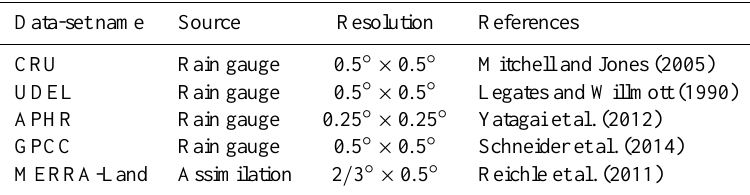
Table 1. The precipitation data sets employed in this